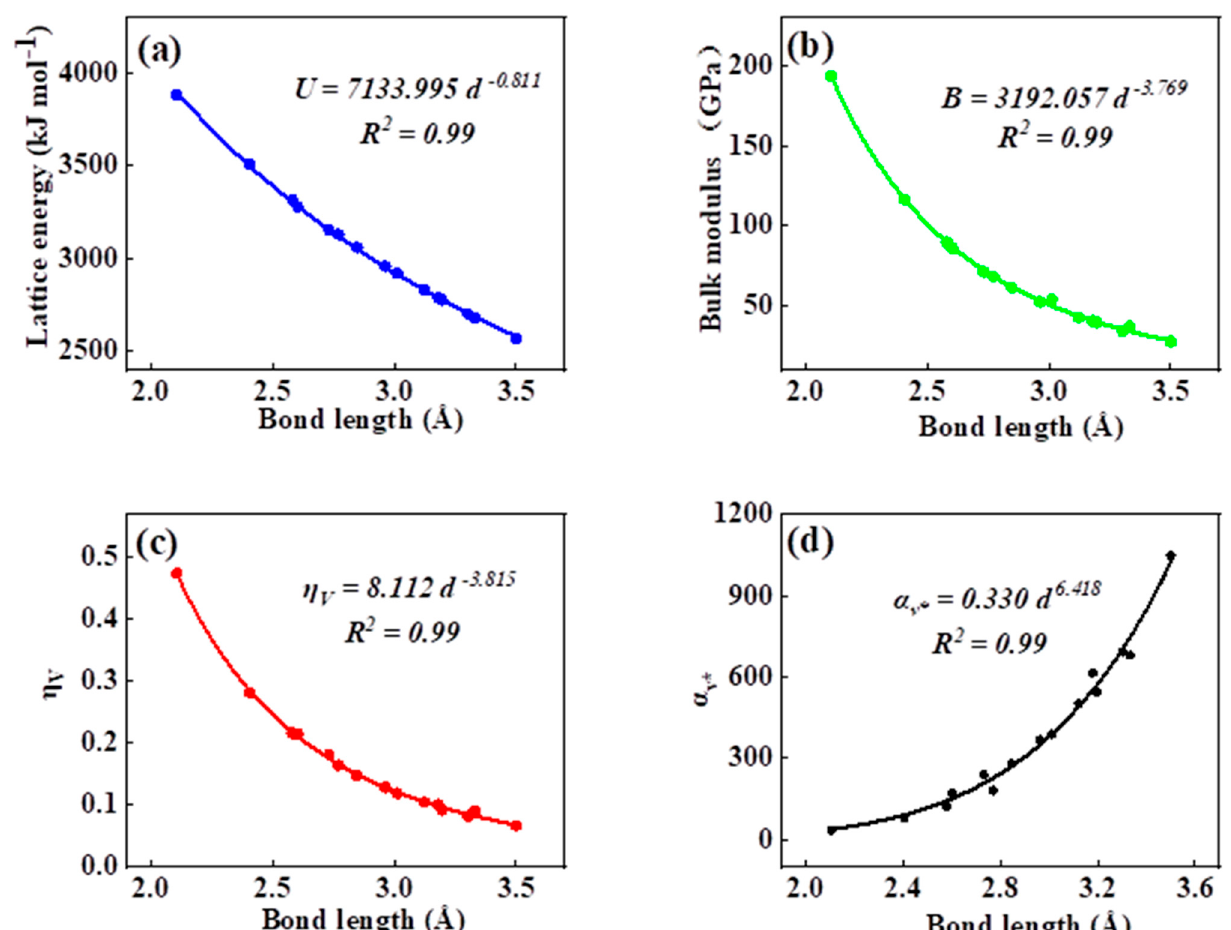
Figure 2. Plot of correlation between the lattice energy, ( a ) bulk modulus, ( b ) chemical hardness density, ( c ) product of electronic polarizability and molar volume, ( d ) and chemical bond length of rock salt crystals of group Ⅱ – Ⅵ .